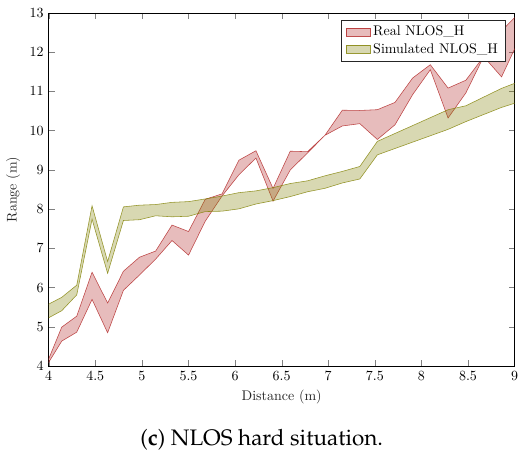
Figure 5. Mean and standard deviation (mean shown in Figure 3 for the three different situations considered.